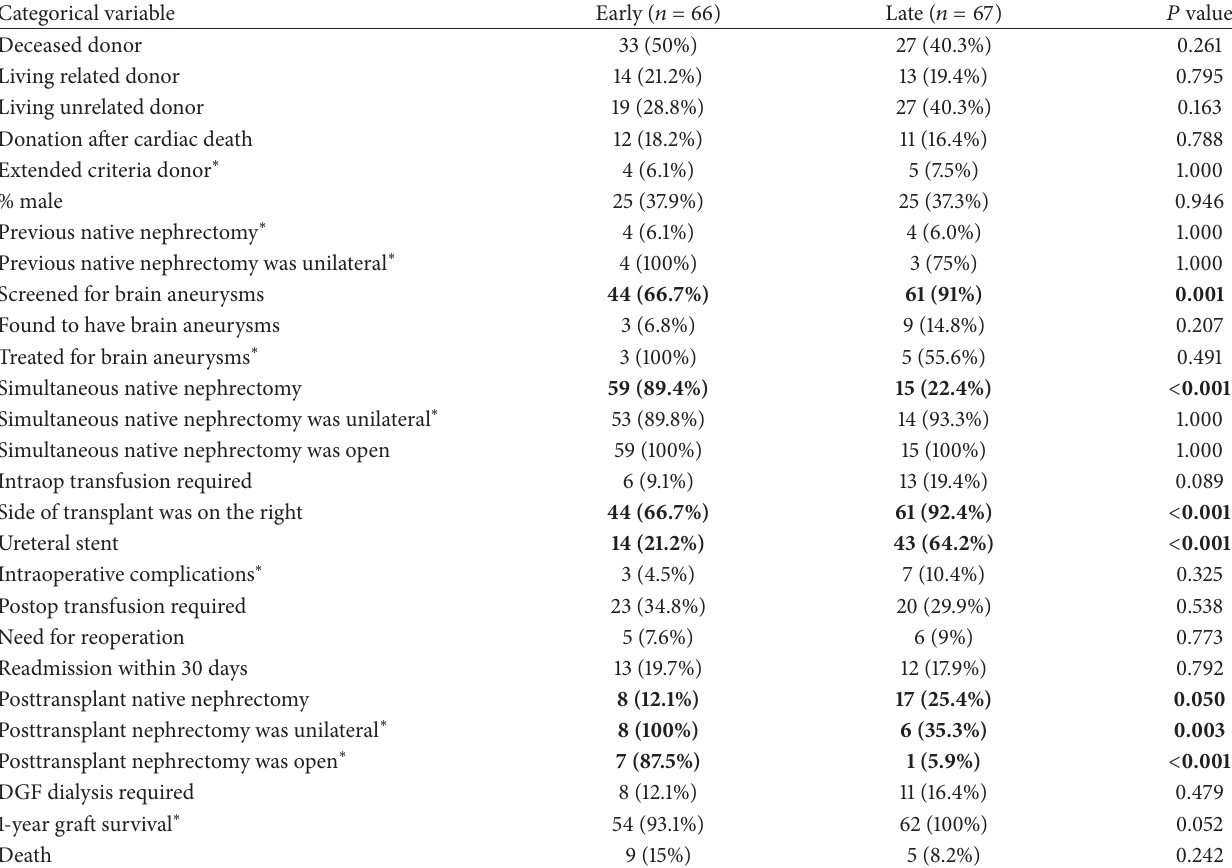
Table 2: Comparison of categorical variables among the early and late experience in patients receiving transplantation for adult polycystic kidney